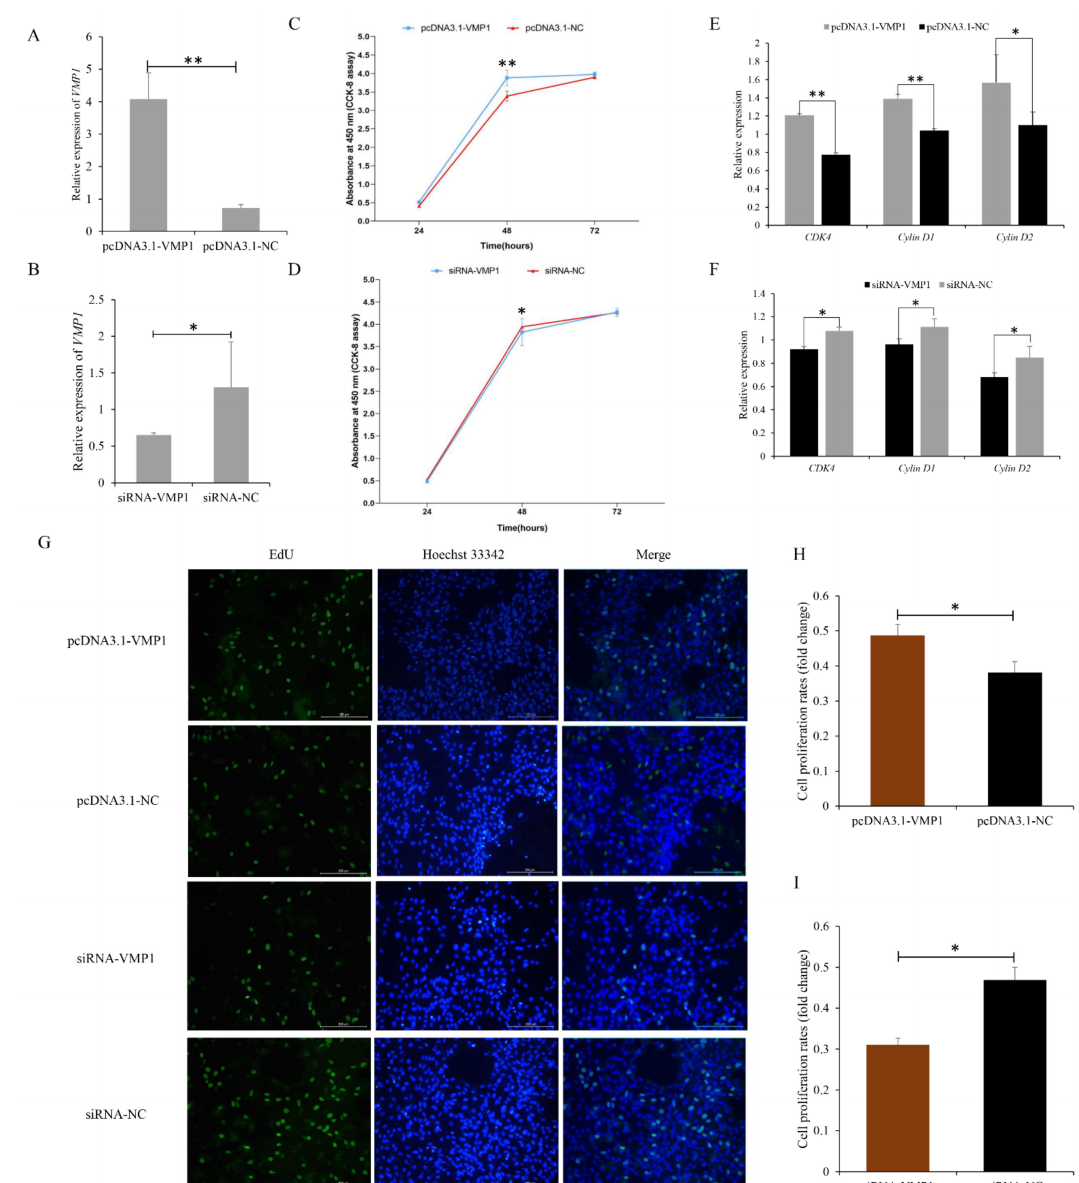
Figure 3. VMP1 regulates the proliferation of goat myoblasts: ( A , B ) RT-qPCR was used to determine VMP1 expression levels in myoblasts transfected with pcDNA3.1-VMP1 and siRNA-VMP1. ( C ) Prolif- eration of goat myoblasts overexpressing VMP1, measured using a Cell Counting Kit-8. ( D ) Prolifera- tion of goat myoblasts transfected with siRNA-VMP1. ( E ) Expression of the cell-proliferation-related genes CDK4, cyclin D1, and cyclin D2 in cells overexpressing VMP1 was determined by RT-qPCR. ( F ) Expression of cell-proliferation-related genes in cells transfected with siRNA-VMP1. ( G ) EdU staining of myoblasts overexpressing VMP1, and in which VMP1 is silenced. ( H , I ) Fold change in the proliferation of myoblasts overexpressing VMP1, and in which VMP1 is silenced. Replicates = 3. Data are shown as the mean ± SE. * p < 0.05 and ** p < 0.01. NC, negative